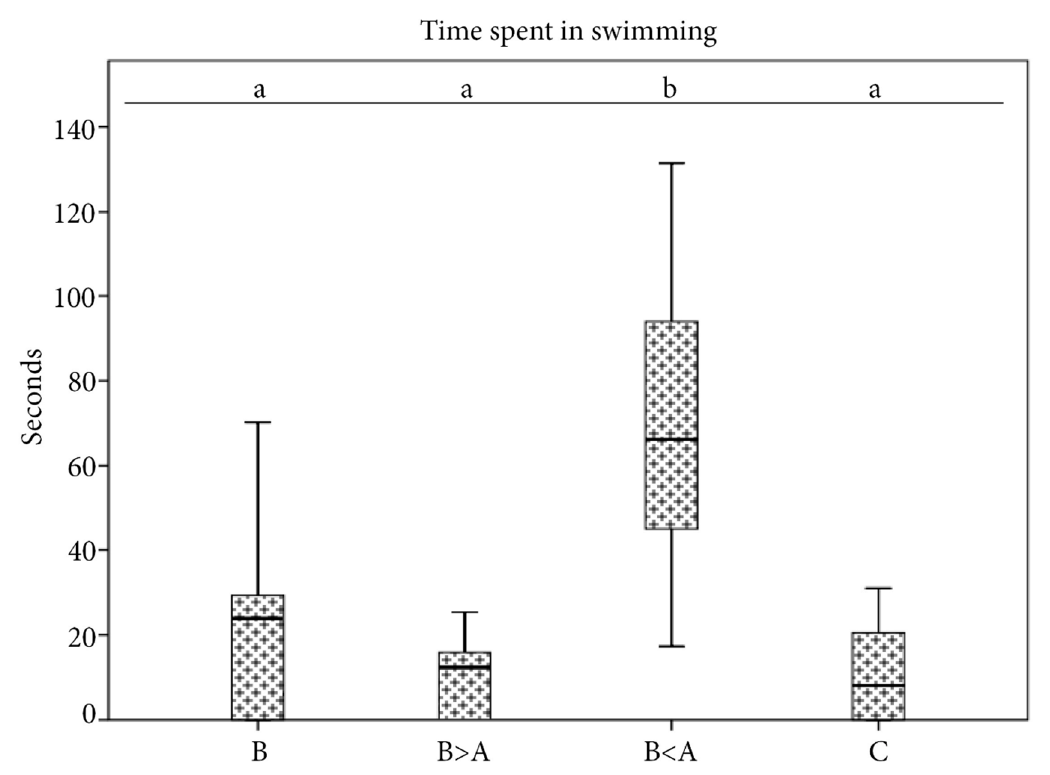
Figure 4. Values (median ± 25th–75th percentiles, whiskers ± 1st–99th percentiles) of the time spent in swimming assessed in S. canicula in the four acoustic experimental conditions. Different letters represent significant differences among the acoustic experimental conditions ( p < 0.05).